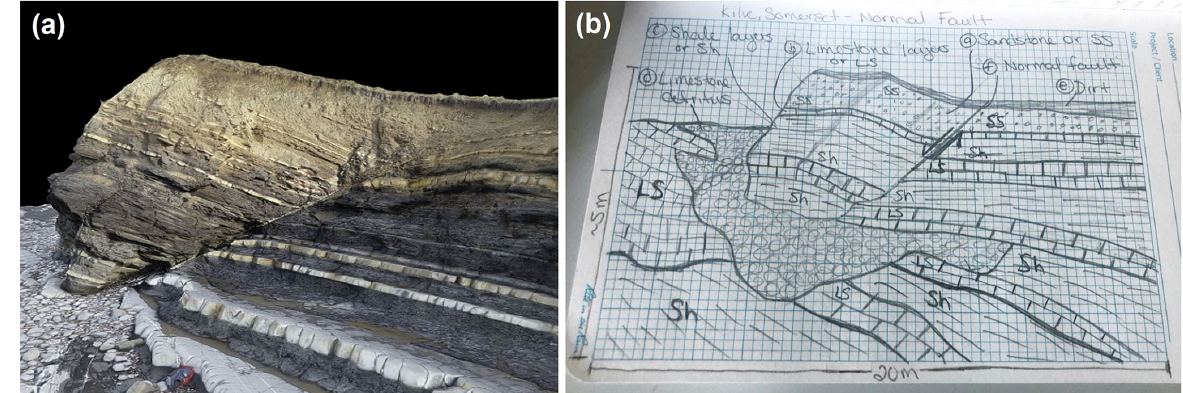
Figure 7. (a) Example 3D photogrammetry outcrop model (Peacock, 2020) and (b) an example sketch